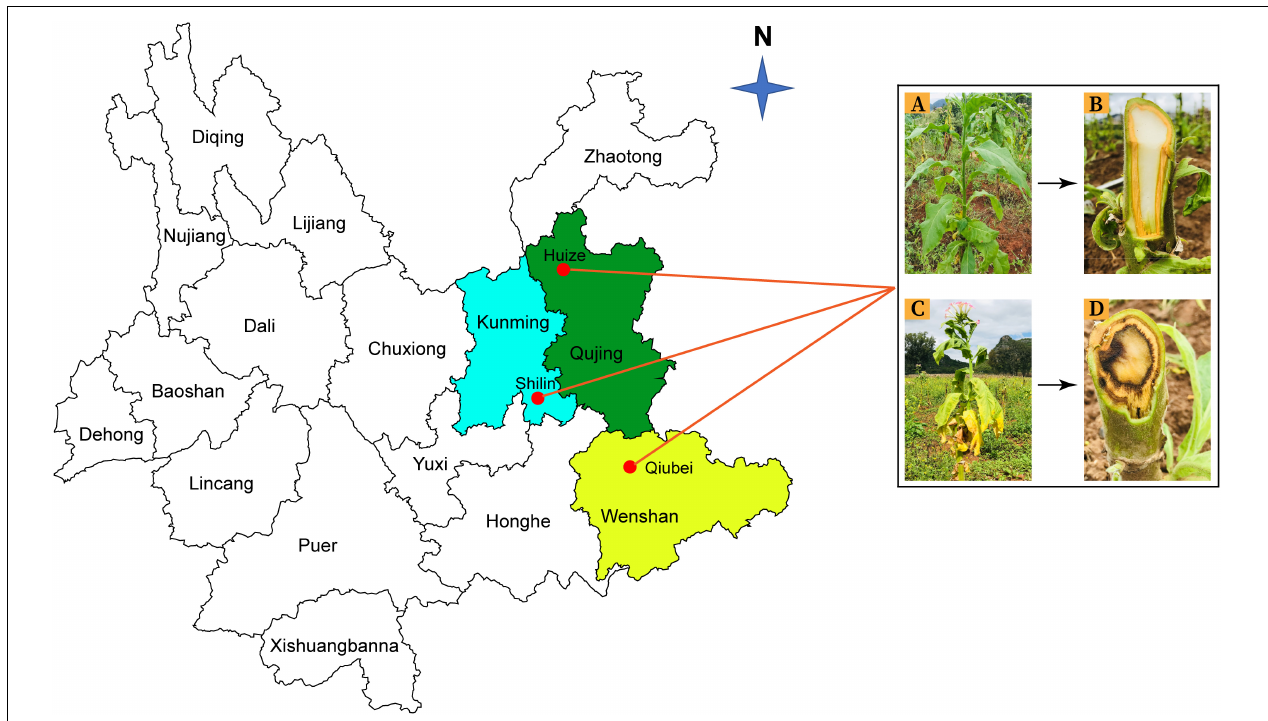
FIGURE 1 | Rhizosphere soil and root samples were collected from three different locations in Yunnan Province: Kunming (Shilin), Qujing (Huize), and Wenshan (Qiubei), from healthy and bacterial wilt infected flue-cured tobacco plants. Healthy flue-cured tobacco plant with green leaves and white-colored xylem vessels (A,B) . Disease flue-cured tobacco plant with typical bacterial wilt symptoms (yellowing, wilting of leaves, necrotic lesions on stem, and discoloration of xylem vessels) (C,D)